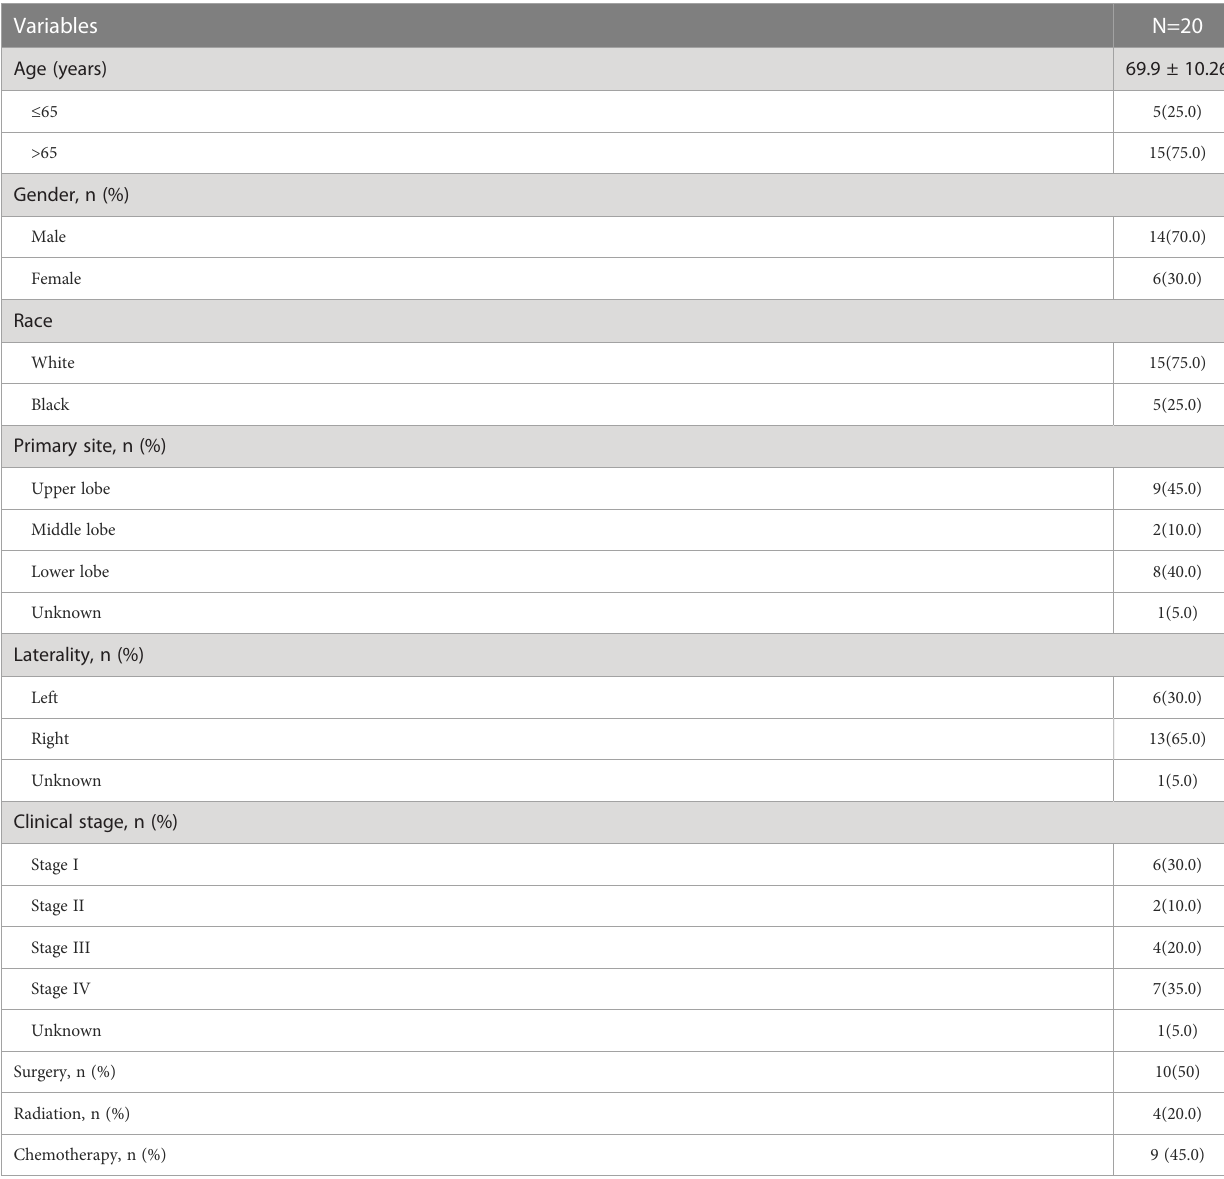
TABLE 4 Clinical characteristics of 20 patients from SEER